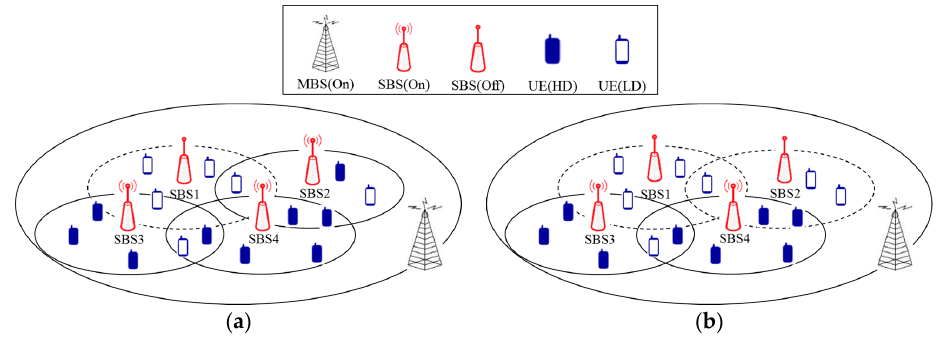
Figure 4. Conventional energy saving operation of BSs in the modified separation architecture ( a ) before energy saving; ( b ) after energy saving.